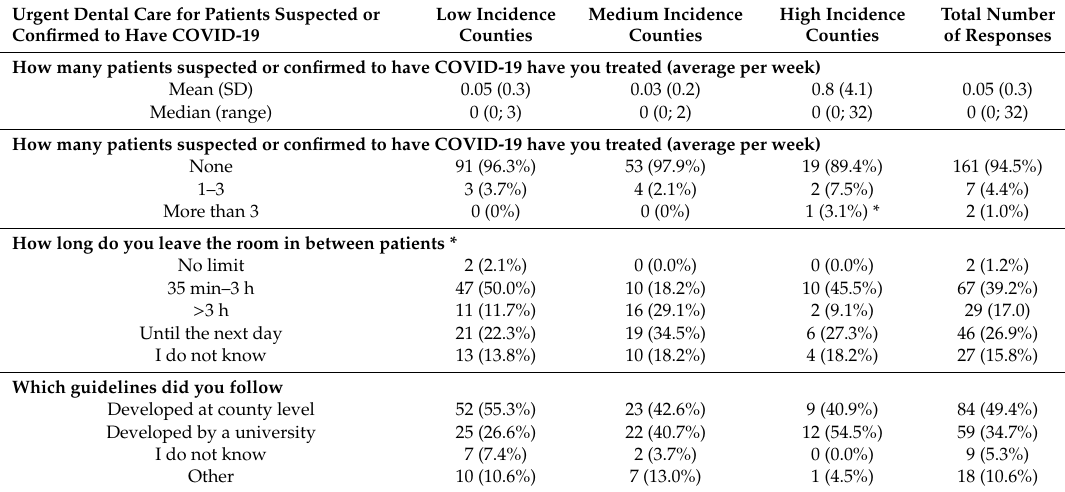
Table 3. Organization of urgent dental care for patients suspected or confirmed to have COVID-19 performed during 13 March, 2020–17 April, 2020, stratified by county incidence